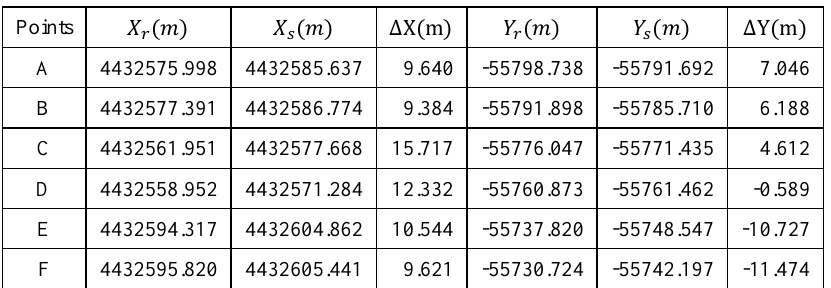
Table 2. Comparison between the coordinates measured by GE and our method ( 𝑋 𝑟 , 𝑌 𝑟 : coordinates measured by GE, 𝑋 𝑠 , 𝑌 𝑠 : coordinates measured by our method)